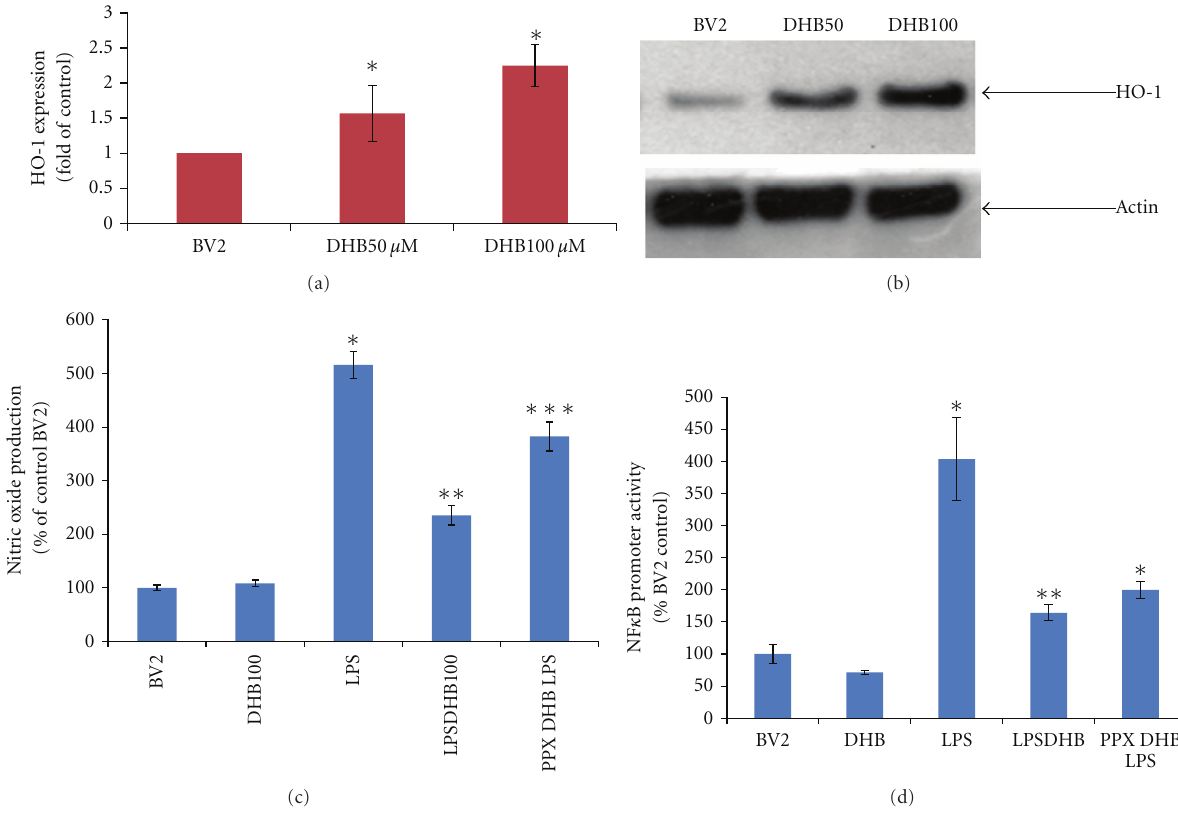
Figure 5: (a) Cells were stimulated with given concentrations of DHB for 6h and mRNA levels of HO-1 analyzed via real-time PCR as described. (b) BV2 cells were stimulated with various concentrations of DHB for 24 h and whole cell lysates subjected to western blot analysis using antibody against HO-1 protein; ∗ P < 0 . 05 versus control. (c) Cells were pretreated with ZnPPIX (20 μ M) for 30 min followed by co-treatment with DHB (100 μ M) for another 1h before LPS (100 ng/mL) addition. Conditioned media (CM) was collected after 24 h of LPS treatment and nitrite levels were determined using the Griess reagent. Each bar represents mean ± SEM from at least four independent experiments. ∗ P < 0 . 05 compared with the control group, ∗∗ P < 0 . 05 compared with the LPS treated group, ∗∗∗ P < 0 . 05 compared with the LPSDHB100 treated group. (d) BV2 NF κ B-Luc cells were pretreated with HO-1 inhibitor ZnPPIX (20 μ M) for 30 min followed by co-treatment with DHB (100 μ M) for another 1h before LPS (100 ng/mL) addition for 4h. Cell lysates were assayed for luciferase activity (mean ± SE, n = 4). ∗ P < 0 . 05 versus control, ∗∗ P < 0 . 05 versus